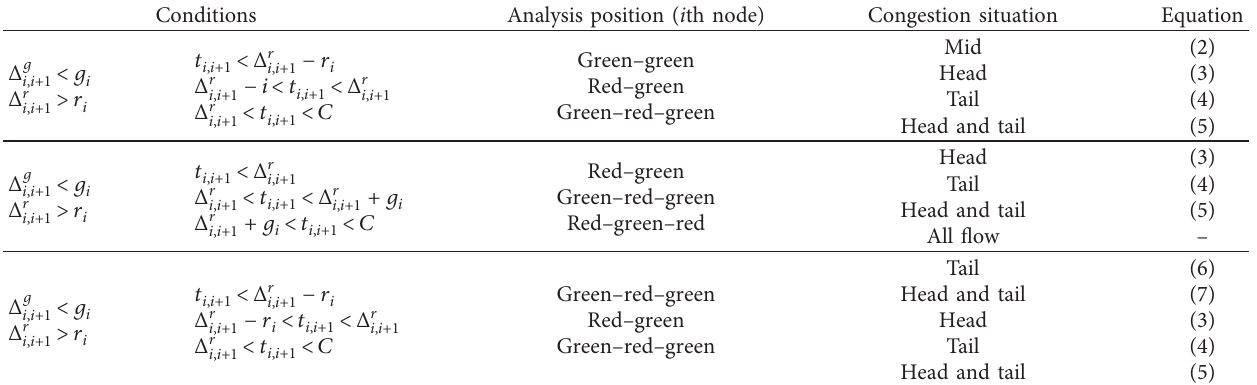
Table 2: Summary of progression bandwidth